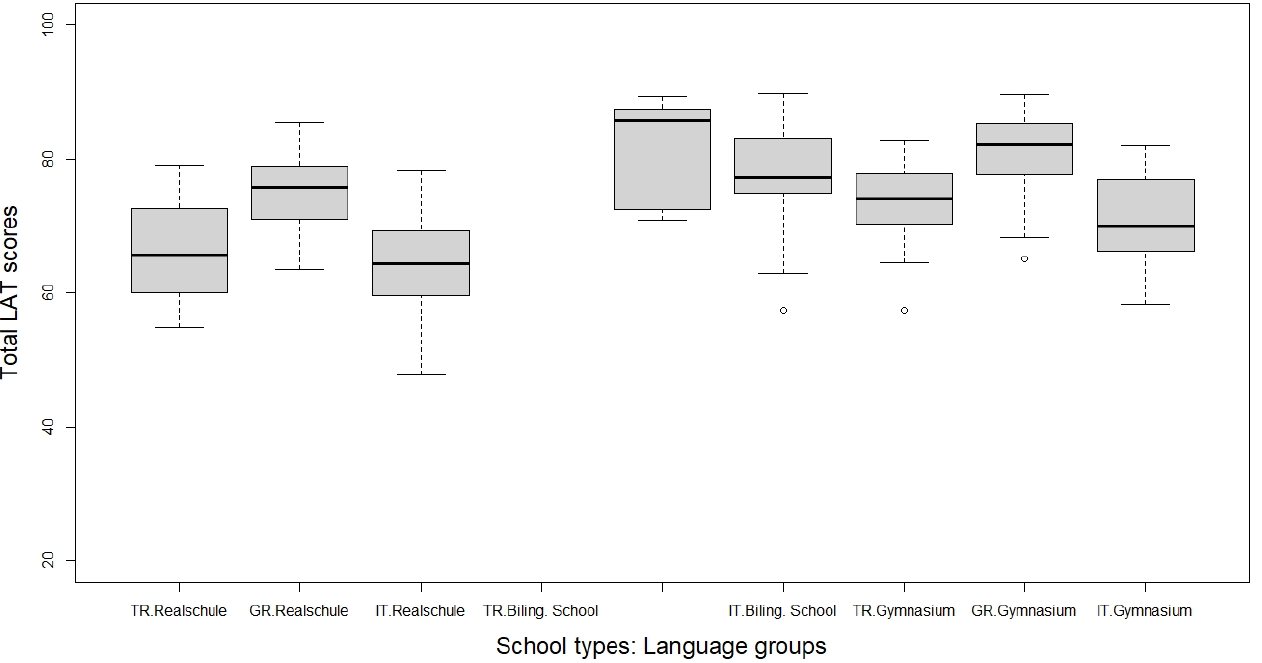
Figure 8. Total LAT scores across school types and language groups.